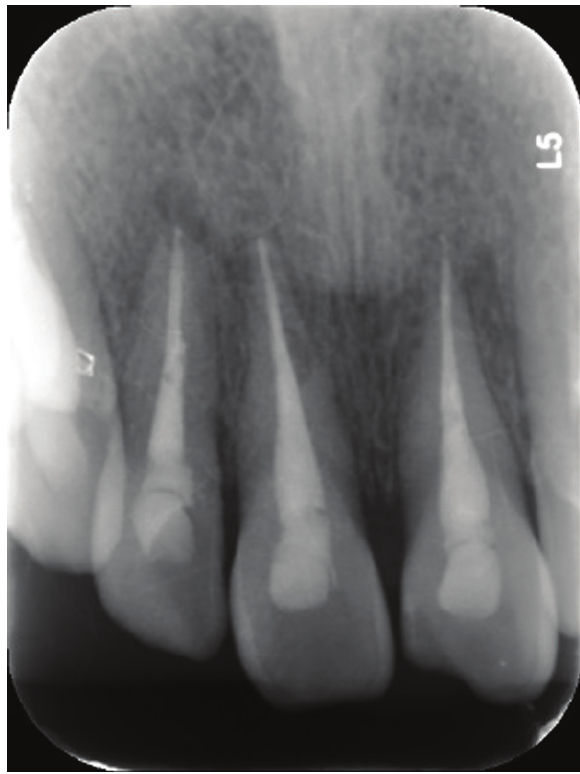
Fig. 4. Diagnostic radiograph showing the IRR lesion of teeth 11 and